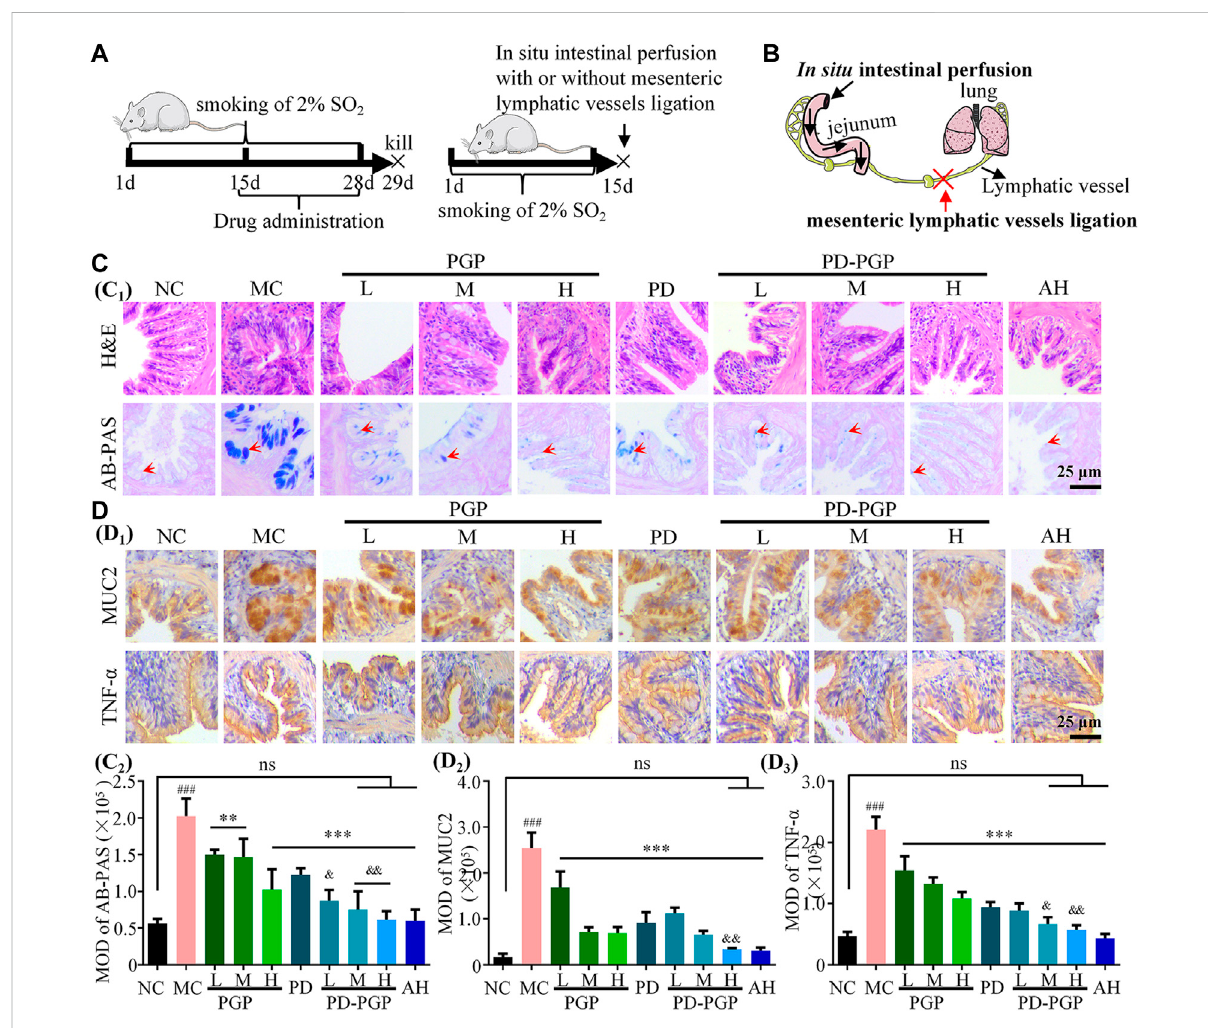
FIGURE 1 Synergistic effects of PD and PGP on ameliorating structural abnormality, excessive mucin secretion, and in fl ammatory state of the lung in CB rats. (A) Experimental design of 2% SO 2 -induced CB model and drug treatment. (B) Illustration of a combination of in situ intestinal perfusion and mesenteric lymphatic ligation. (C) Representative H&E-staining and AB-PAS staining images (C1) and MOD analyses (C2) of lung tissues after administrationwithlow/medium/highdoseofPGP(75,150and300 mg/kg,groupsPGP L/M/H ),PD(2 mg/kg,groupPD),PD+low/medium/high dose of PGP (groups PD-PGP L/M/H ), and positive drug ambroxol hydrochloride (8.1 mg/kg, group AH), with the lung from groups NC and MC as a comparison. (D) Representative images (D1) and MOD analyses (D2 and D3) of IHC staining MUC2 and TNF- α expression in lung tissues after administration with PGP, PD, and PD-PGP, with the lung from groups NC and MC as a comparison. [Original magni fi cation ×200. Red arrow, acidic mucus. Data are expressed as mean ± SD, with data obtained from 10 randomly selected fi elds. Data are expressed as mean ± SD ( n = 6); ** p < 0.01 and *** p < 0.001 versus MC group; ### p < 0.001 versus NC group; & p < 0.05, && p < 0.01 and &&& p < 0.001 versus PD